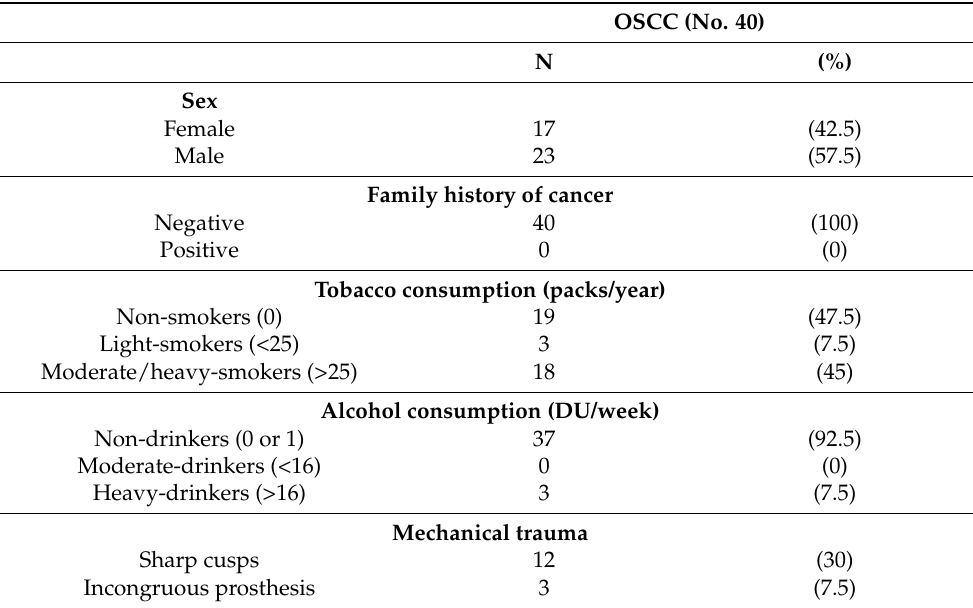
Table 1. Information regarding sex, family history of cancer, tobacco (packs/year) and alcohol consumption (drink units-DU/week), and mechanical